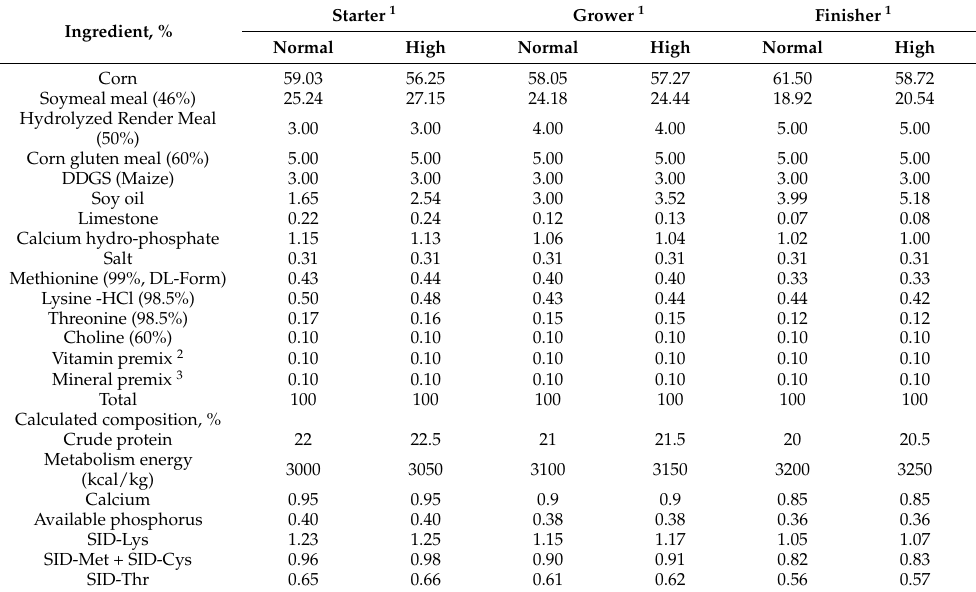
Table 1. Basal diet composition (as-fed